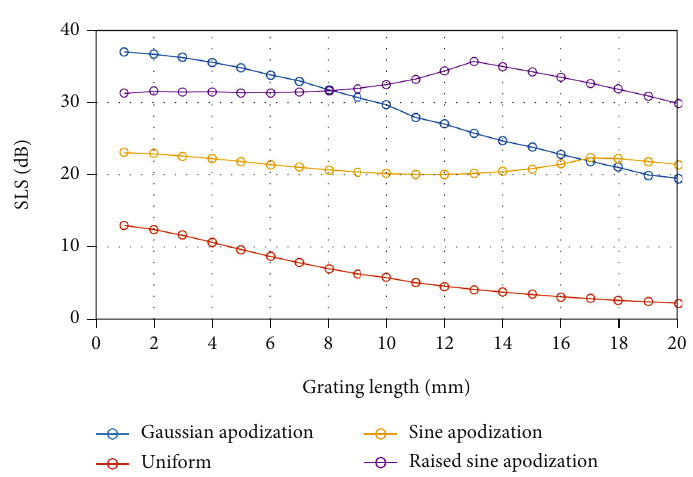
Figure 10: Side-lobe suppression versus the grating length of